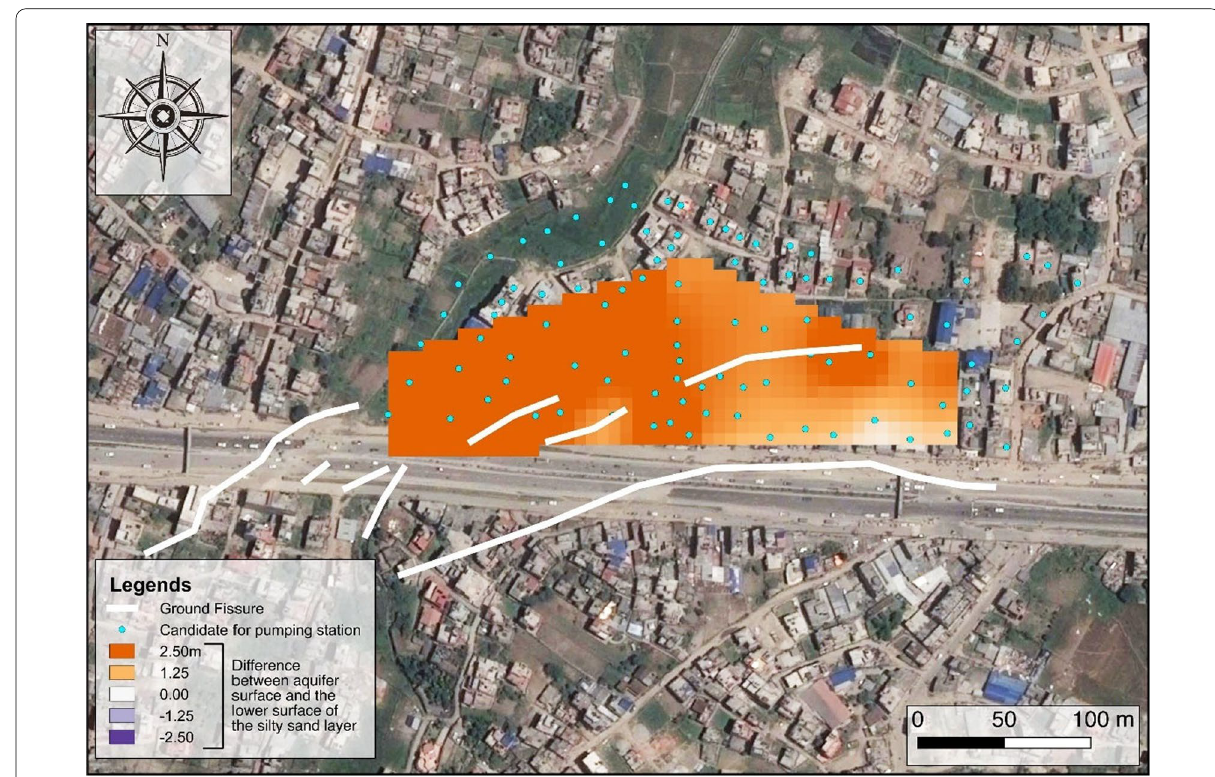
Fig. 9 Difference between the upper surface of the aquifer and the lower surface of the silty sand layer in Kausaltar (before lowering groundwater